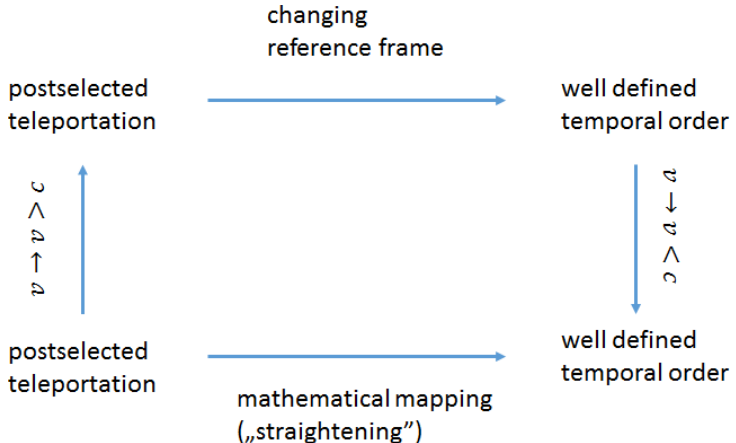
Figure 3 . Physical interpretation of Lloyd-Preskill mapping as change of reference frame in the case of super-luminal particle A